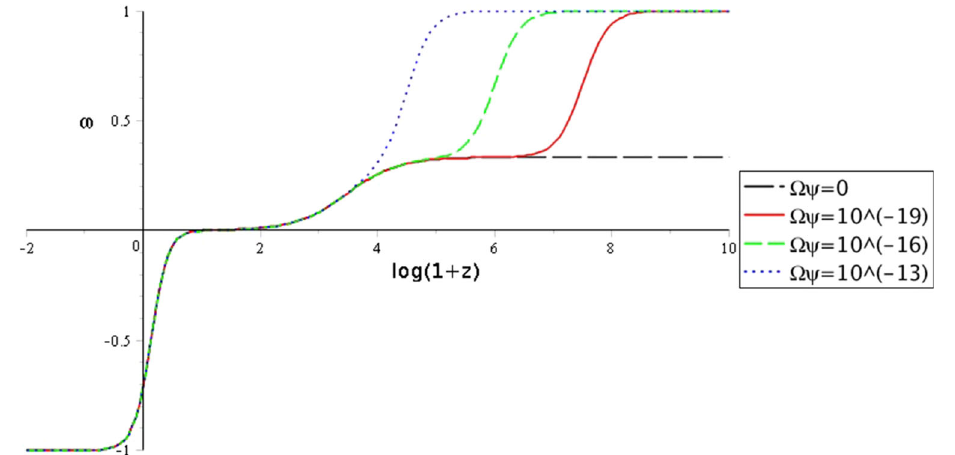
Fig. 1 Theevolutionof w forthe (cid:3) CDMmodelwithanadditionalfree scalar field. The parameters are set (cid:5) (cid:3) : (cid:5) M : (cid:5) RD = 0 . 7 : 0 . 2999 : 0 . 0001 as of today. The effect of the scalar field is also included by